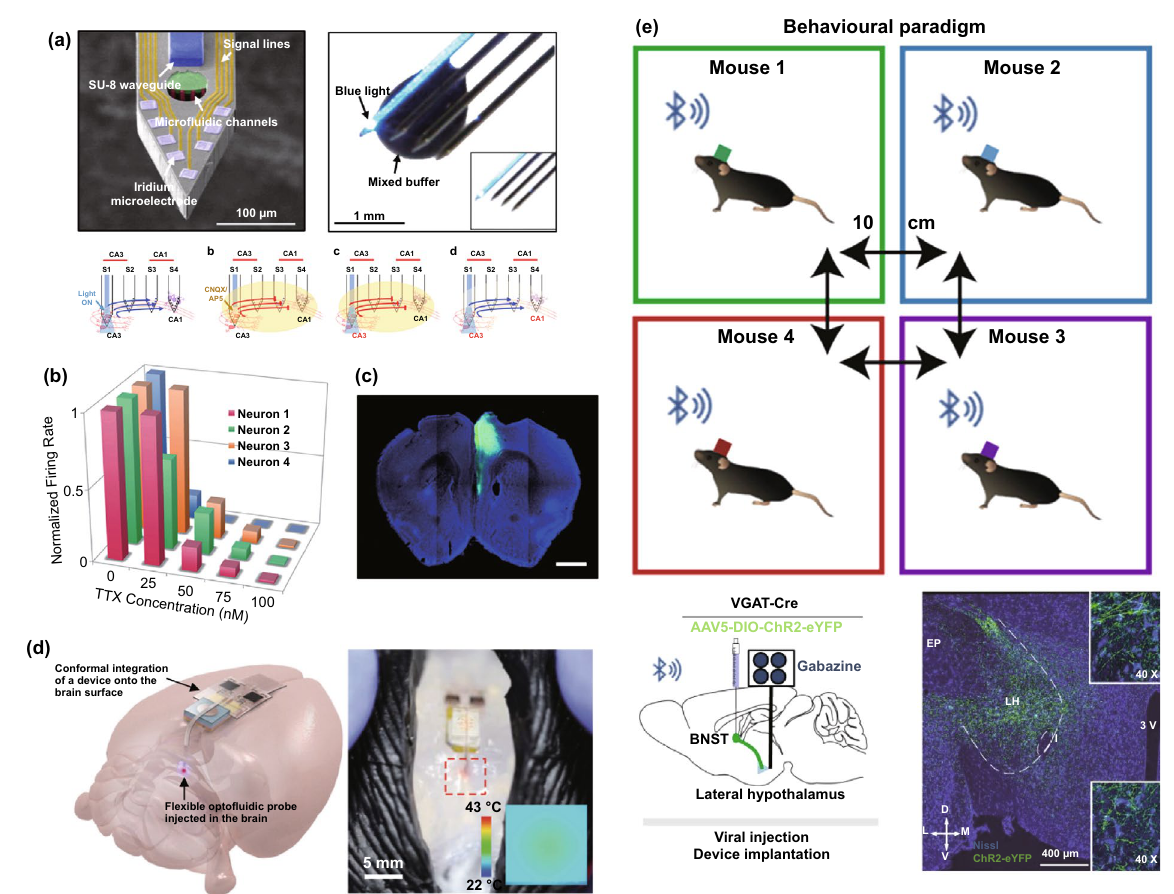
Fig. 21 Semi‑implantable drug delivery devices for brain in vivo. a A multifunctional multi‑shank with single channel microfluidic for drug delivery neural probe to study and modulate remote neural circuits in vivo [349]. b In vivo direct injection of pilocarpine recording that four sorted neurons at 5 different concentrations of pilocarpine by microfluidic channels [47]. c The expression of opsin gene in wild‑type (WT) mice was detected after the viral vector carrying opsin gene was injected into WT mice by dual channel microfluidic probe [350]. d Wireless delivery of red dye to the phantom brain in the rat model by single channel optofluidic system [351]. e Wireless, selective control of drug delivery in a group of concurrently behaving mice [352]. Reproduced with permission from Refs. [349–352], copyright (2019) Nature Publishing